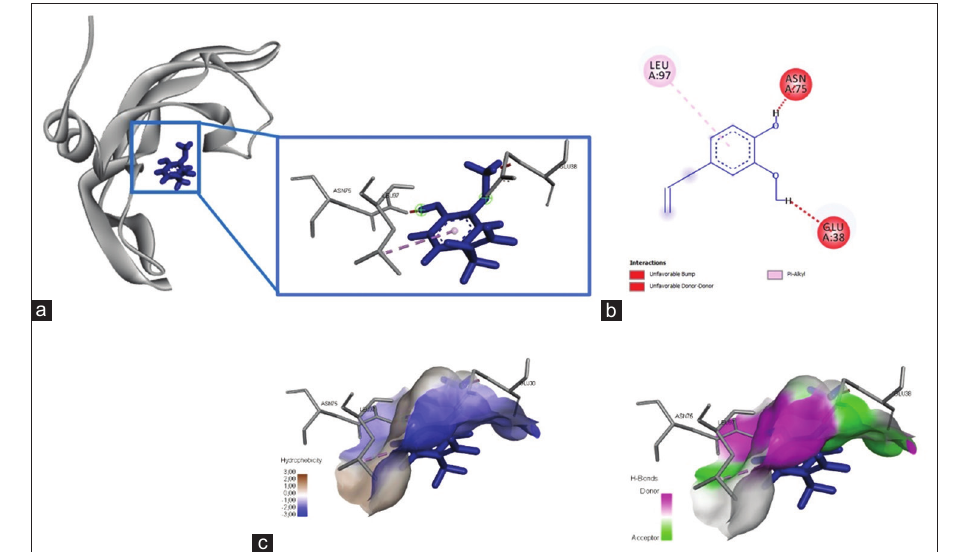
Figure-10: The visualization of the three-dimensional and two-dimensional interaction between phenol compounds (eugenol) and vascular endothelial growth factor (VEGF). (a) Three-dimensional structural interaction between the ligand eugenol (blue) and VEGF (gray). (b) This interaction is built by hydrophobic hydrogen bonds on the active site of VEGF, namely, Leu97, Glu38, Asn75, which can be seen in the two-dimensional (b) and three-dimensional (c) structures.